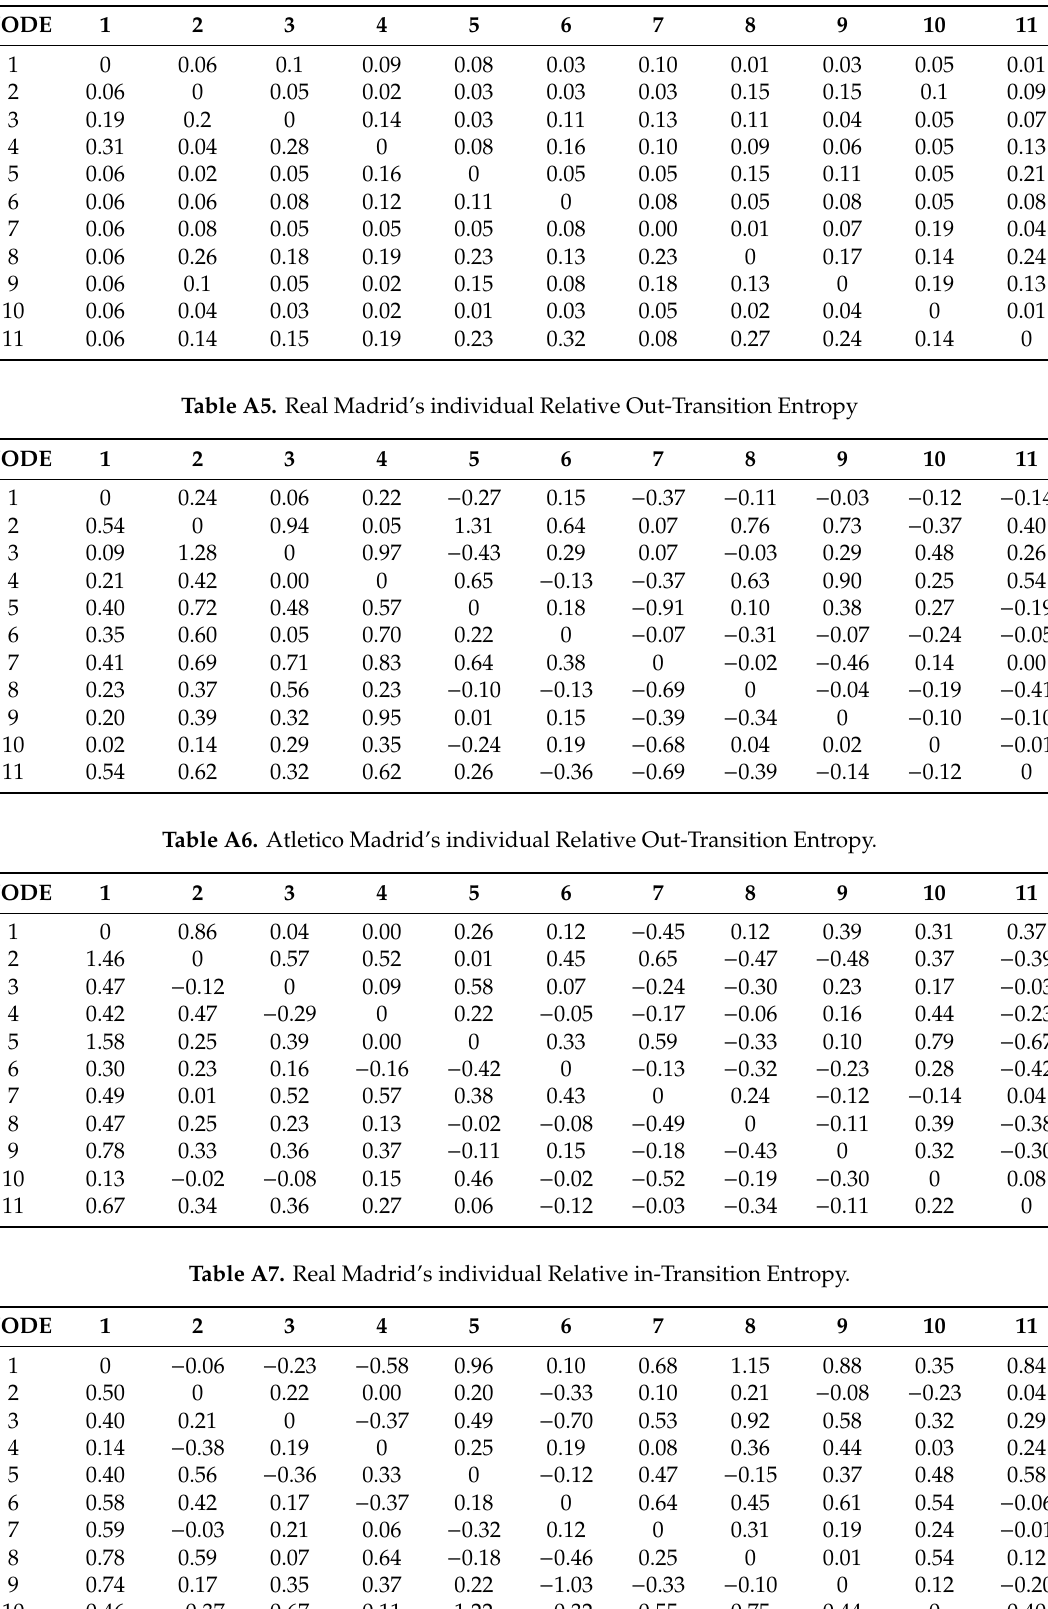
Table A4. Atletico Madrid’s matrix of state in-transition probabilities.